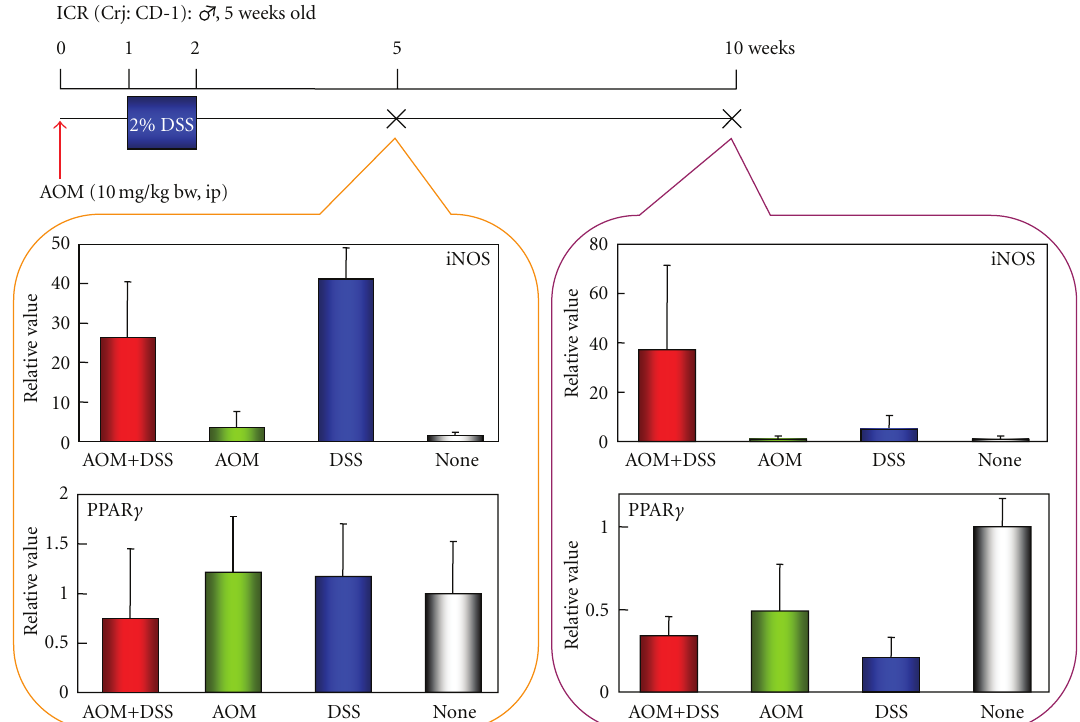
Figure 12: Real-time PCR analysis of iNOS and PPAR γ in the colonic mucosa of mice that received AOM and DSS at weeks 6 and 10.